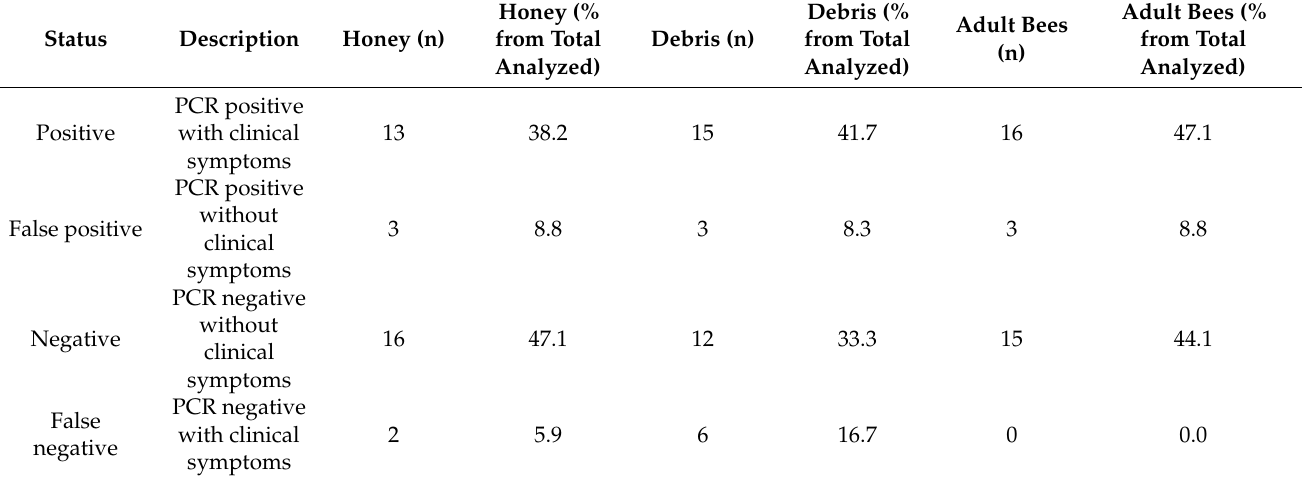
Table 2. Overview of the PCR results obtained for each sample matrix normalized to the clinical inspections.